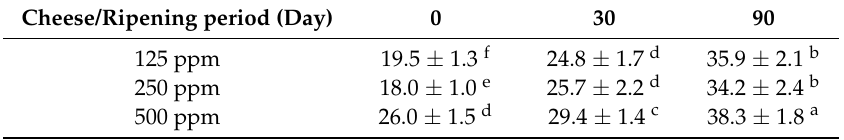
Table 4. Mean recovery (%) of free (+)-catechin in digested cheese samples measured by HPLC ( n = 4). Cheese/Ripening period